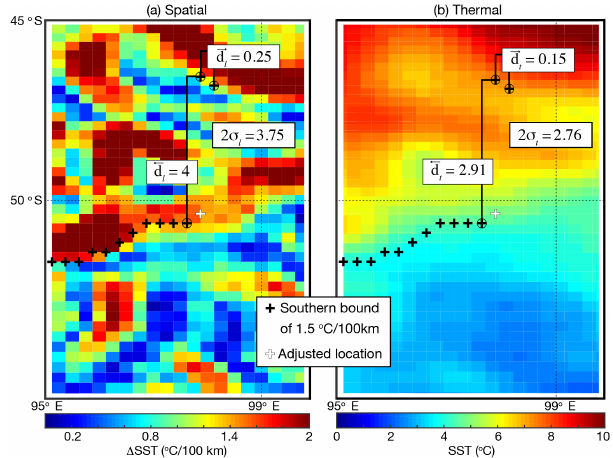
Figure 1. Example of (a) spatial and (b) thermal discontinuity re- sulting in an adjustment in the PF location according to Eq. (1) as outlined in Sect. 2.2.2. d l , 2 σ l in units of ◦ latitude and d t , 2 σ t in units of ◦